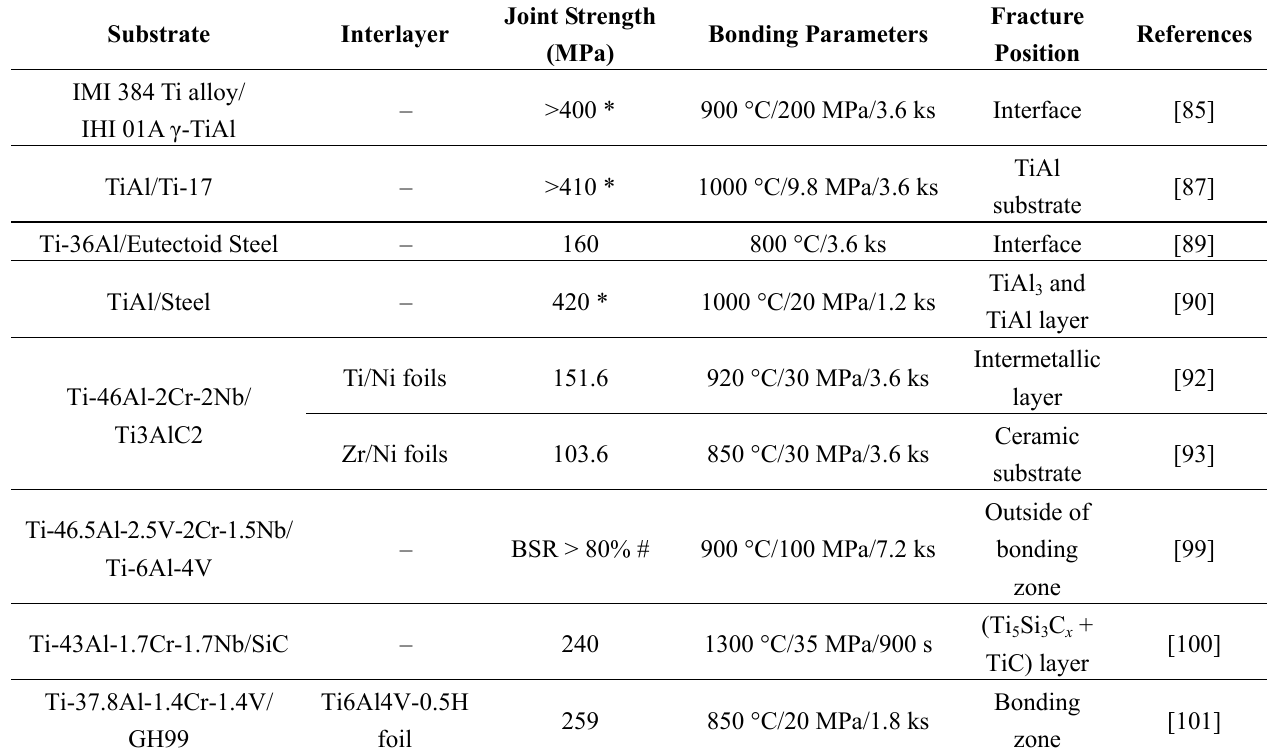
Table 5. Mechanical properties of titanium aluminides/other materials diffusion bonded